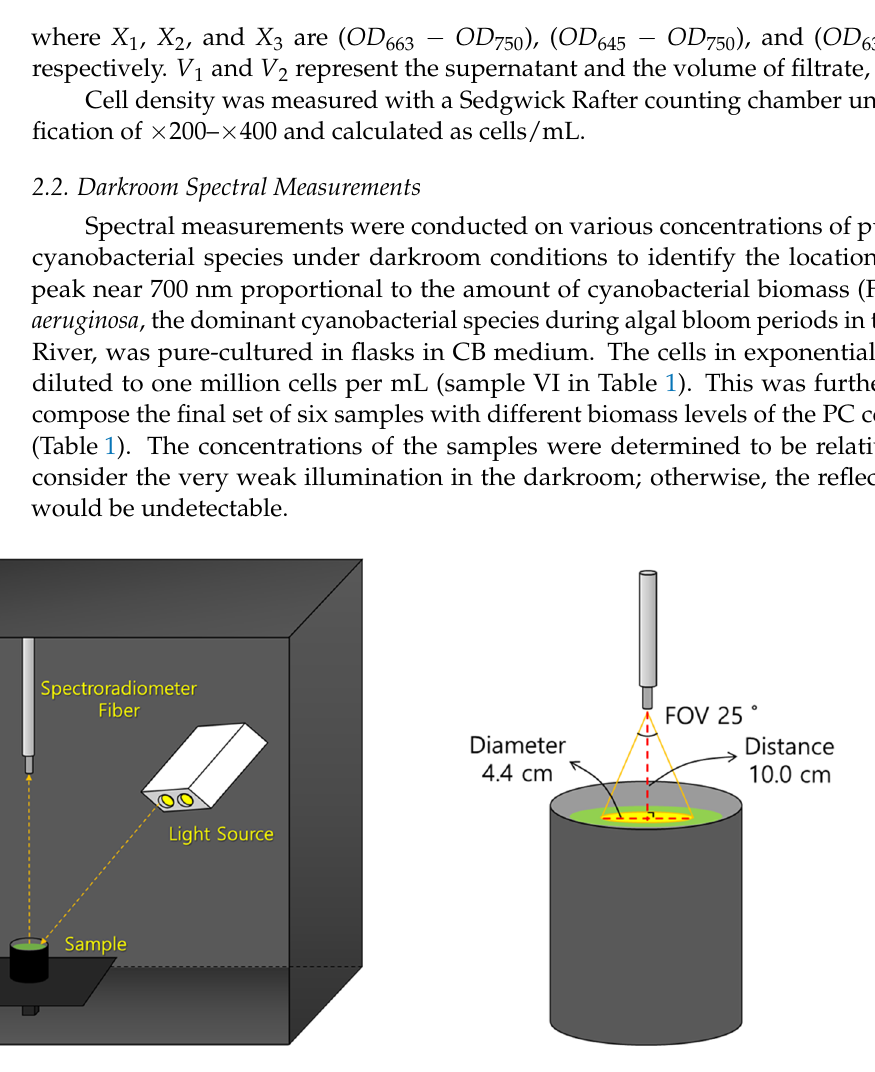
Figure 2. Darkroom setup for the spectral measurements of the algae; ( left ) schematic of the darkroom experimental design; ( right ) sensing geometry of each sample in the beaker. Table 1. Sample design for spectral measurements in a darkroom